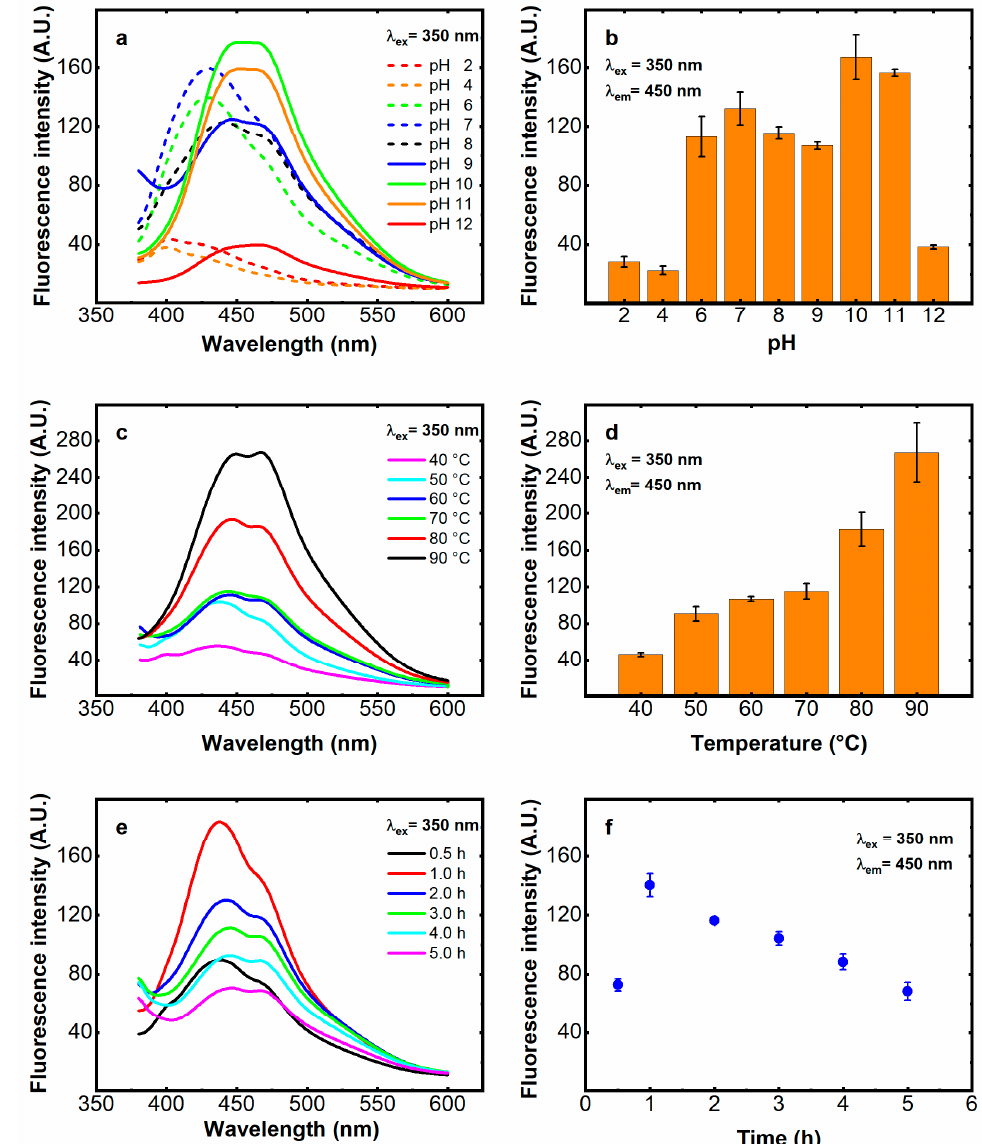
Figure 3. Fluorescence emission ( λ ex = 350 nm, λ em = 450 nm) of serotonin-derivative fluorophore (SEDF) obtained by heating 2.0 g L − 1 SE monomer. The influence of pH 2–12 ( a , b ), temperature 40 ◦ C–90 ◦ C ( c , d ), and reaction time 0.5–5 h ( e , f ) on the fluorescence emission spectra (left) and intensity at 450 nm (right). The error bars represent the standard deviation (n =